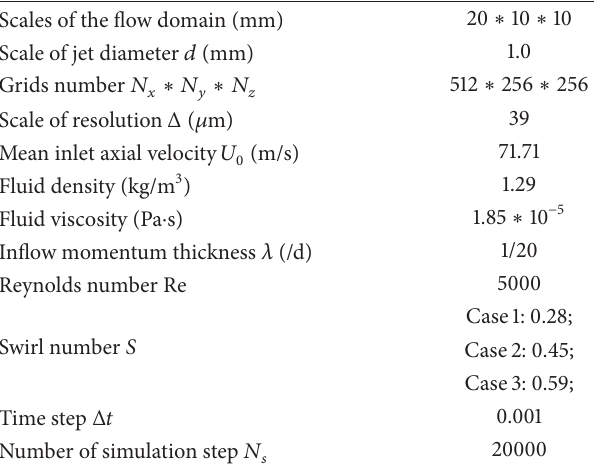
Table 1: Typical real values of variables used in the numerical